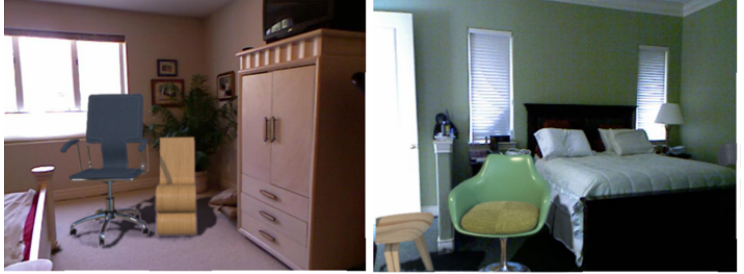
Figure 10. Example of embedding 3D objects in NYUv2 dataset [38].